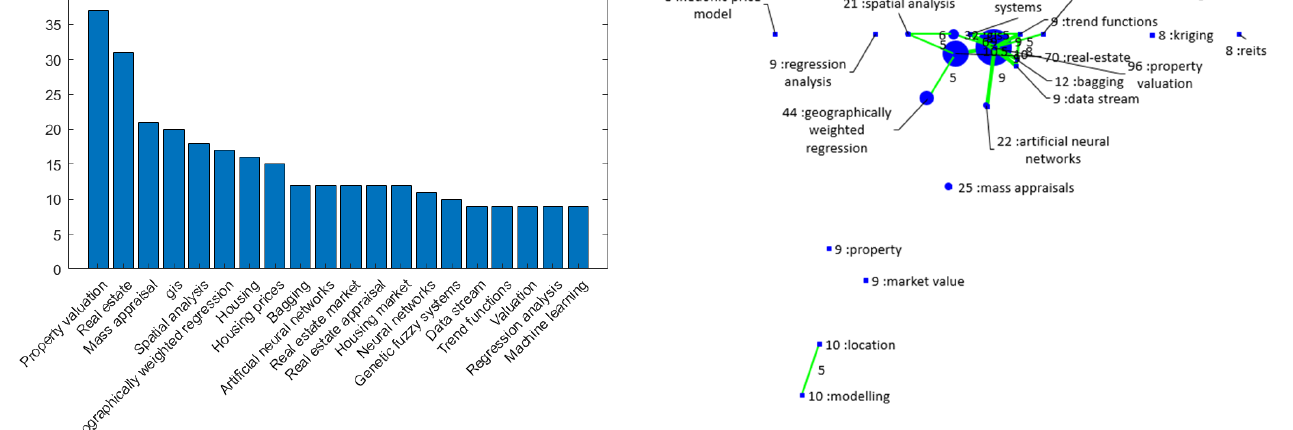
Figure 4. Bibliometric Map of the keywords.